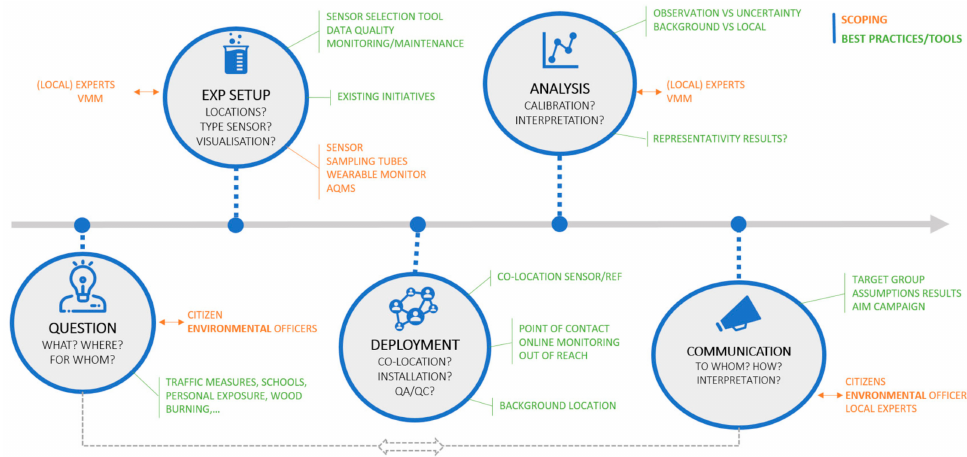
Figure 12. Blueprint for a municipal air quality sensor network. Scoping (orange) and best practices (green) based on real-world experiences are given for each step in the design